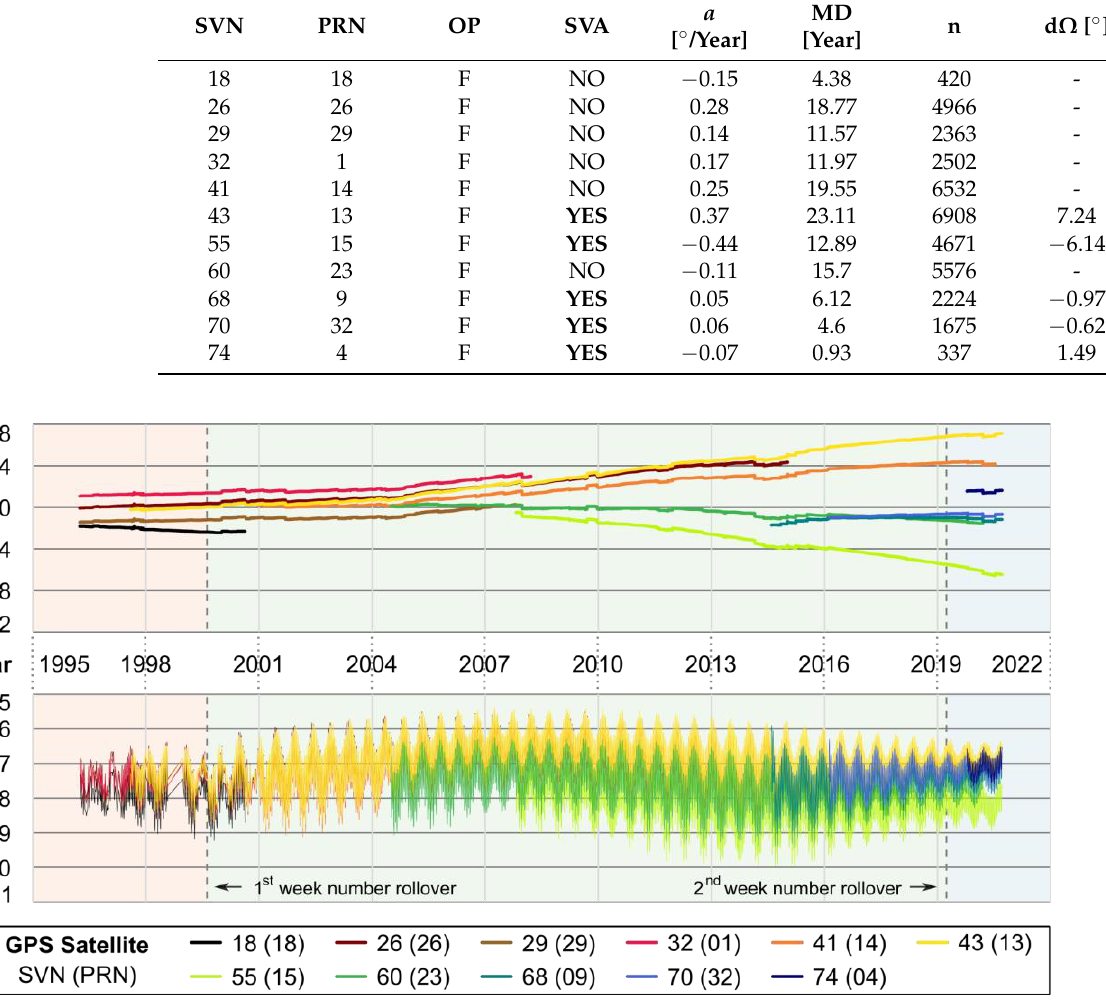
Figure A5. Separation of satellite ANs from the hex-LS-estimated position of the OP F AN with satellite dot(Ω) values.